Question: Summarize what this figure shows in one sentence.
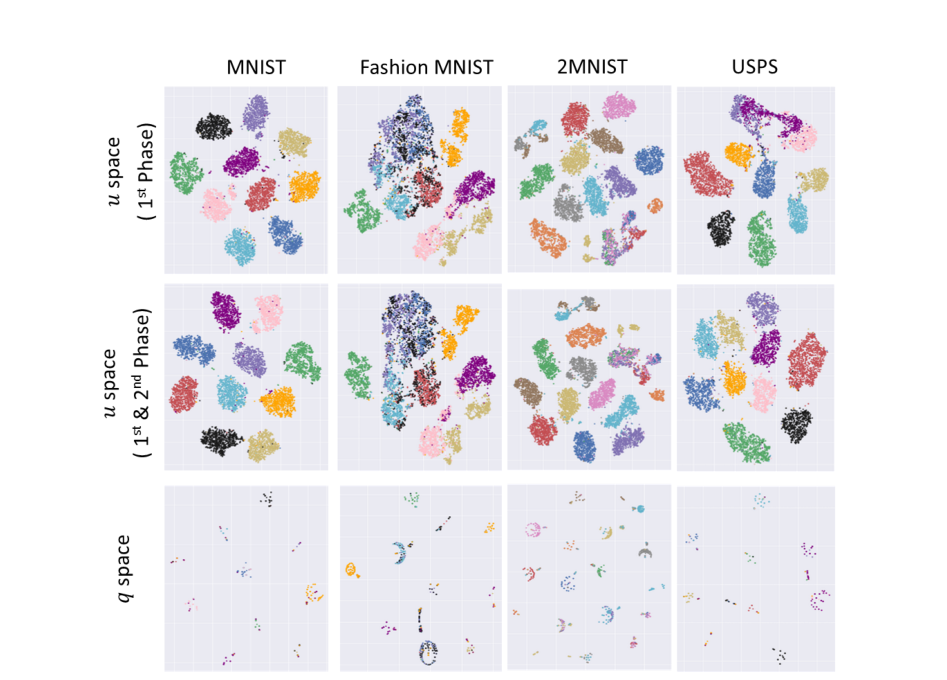
Answer: Clustering visualization of different phases of DCSS using t-SNE for different benchmark datasets. For reference, the visualization for the baseline model AE+k-means is shown in the first row. Axes range from -100 to 100.